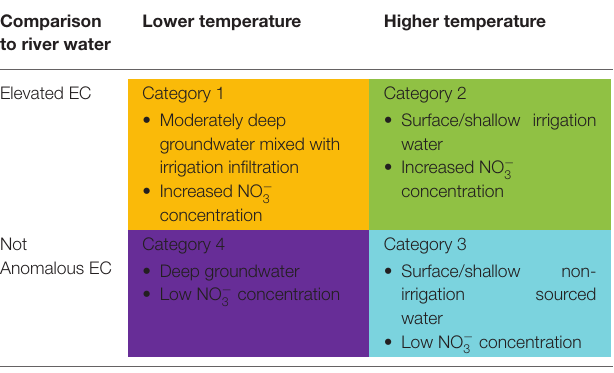
TABLE 2 | Summary of anomaly interpretations. Comparison to river